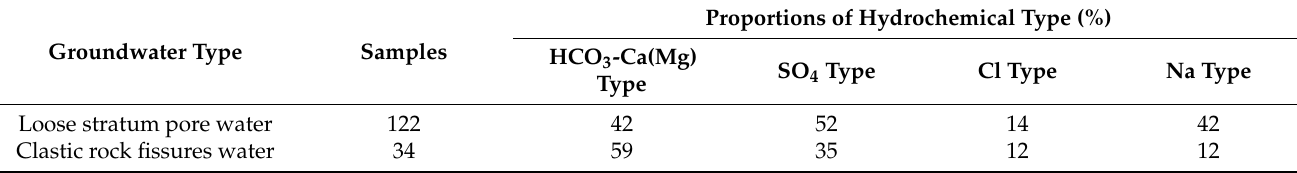
Figure 6. Hydrochemical type of groundwater for the sampling site in Huangshui River basin. Table 4. Statistic table of groundwater hydrochemistry type of different type groundwater in this region.